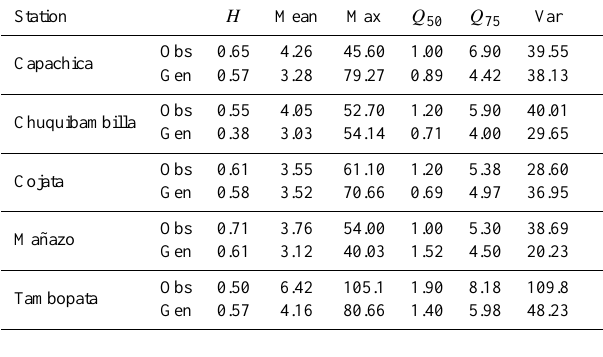
Table 4. Statistics of temporal information during the wet season (November–March) from 1999 to 2006.